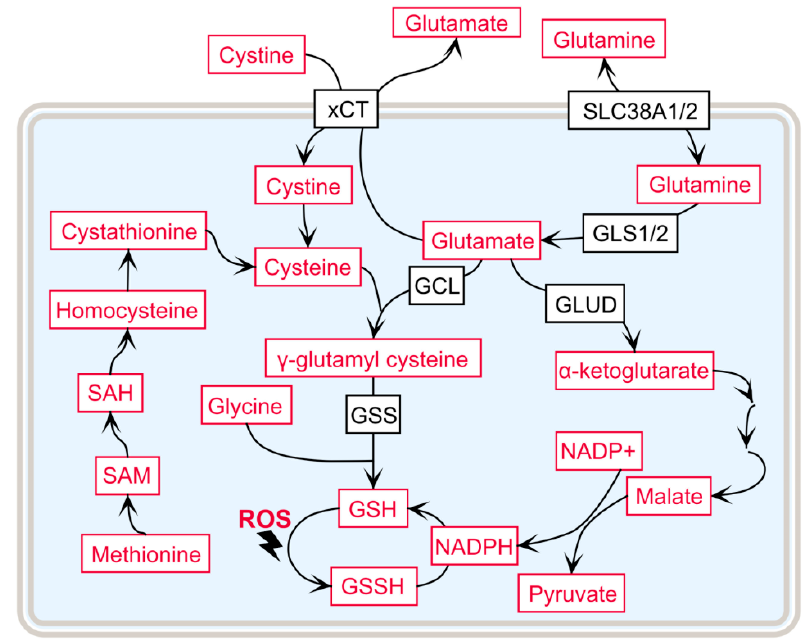
Figure 2. The availability of the precursor amino acids that influence GSH synthesis. Color codes are defined as follows: black = enzymes or transporters; red = metabolites. SLC38A1/2: solute carrier family 38 member 1 and 2, glutamine transporters; GLUD: glutamate dehydrogenase; SAM: S-adenosyl methionine; SAH: S-adenosyl homocysteine.